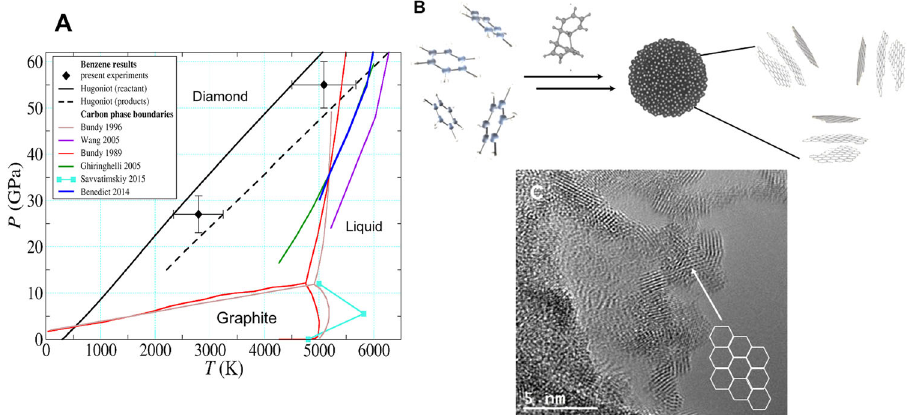
Fig. 5 The products of shock-driven benzene on the principal Hugoniot form from dimerization and polymerization, followed by condensation into clusters with the sheet-like structure of sp 2 – sp 3 character. A Carbon phase diagram showing diamond, graphite and liquid regions from several works (see legend) 62 – 64,66,71,72 . A region of transition from sp 2 – sp 3 hybridized allotropes is proposed to occur in the diamond region by Blank et al. 73 – 75 . P – T states along the principal reactants and products Hugoniots, and the calculated P – T states from shocked benzene (this work) are overlaid on the phase diagram (errors as reported in Table 1 and Supplementary Note 1). B Schematic of the proposed mechanism of cluster formation from benzene. Shocked liquid benzene undergoes dimerization and polymerization addition reactions to form clusters with disordered, hydrogenated layered carbon structures with sp 2 – sp 3 character. C Transmission electron micrograph of recovered carbon from PBX 9502, and explosive that samples a similar P – T condition to the experiments described here, showing the transition from layered- sp 2 to sp 3 - diamond-like structures within the structure. Recovery of products from the laser-driven shock compression experiments of benzene was not